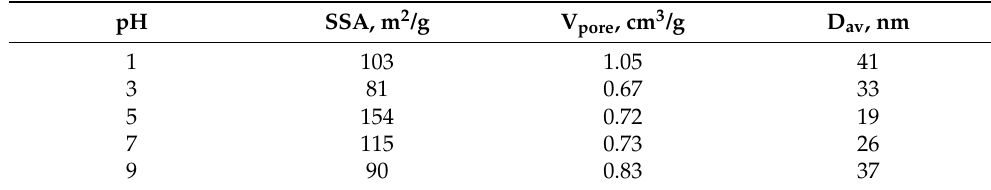
Table 1. Textural characteristics of the Ni-Mg-O samples obtained at various pH.